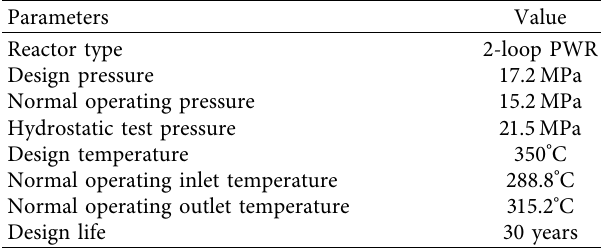
Table 1: The main parameters of the referenced